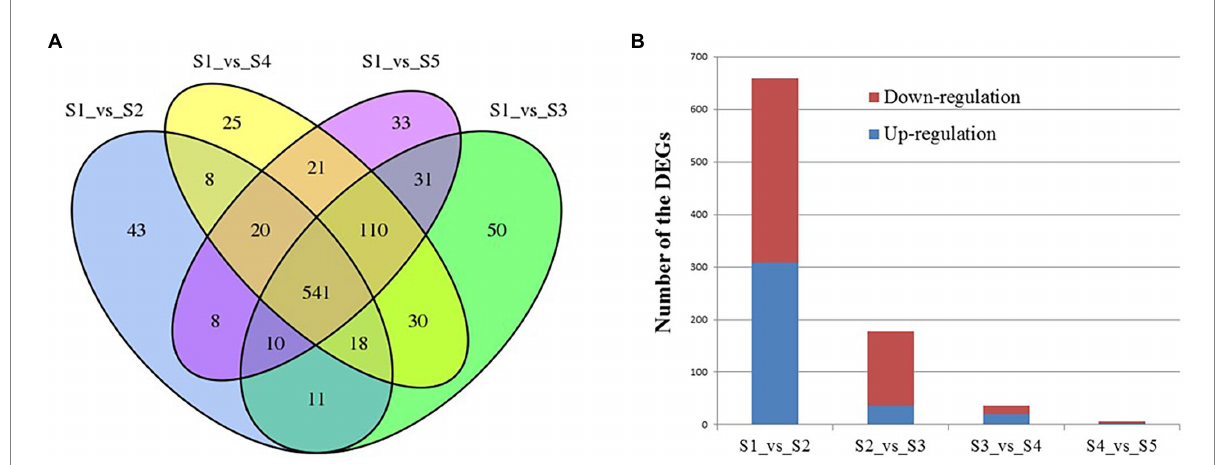
FIGURE 3 Analysis of the differentially expressed genes of B. subtilis 1JN2 after Cd2 + treatment. (A) Venn diagram analysis, (B) numbers of DEGs between time points. Samples collected at 6 h, 12 h, 18 h, and 24 h were named as S2, S3, S4, S5 and the blank control that without Cd2 + was named as S1. Comparison between S1 and S2 means the DEGs between the two samples, and so